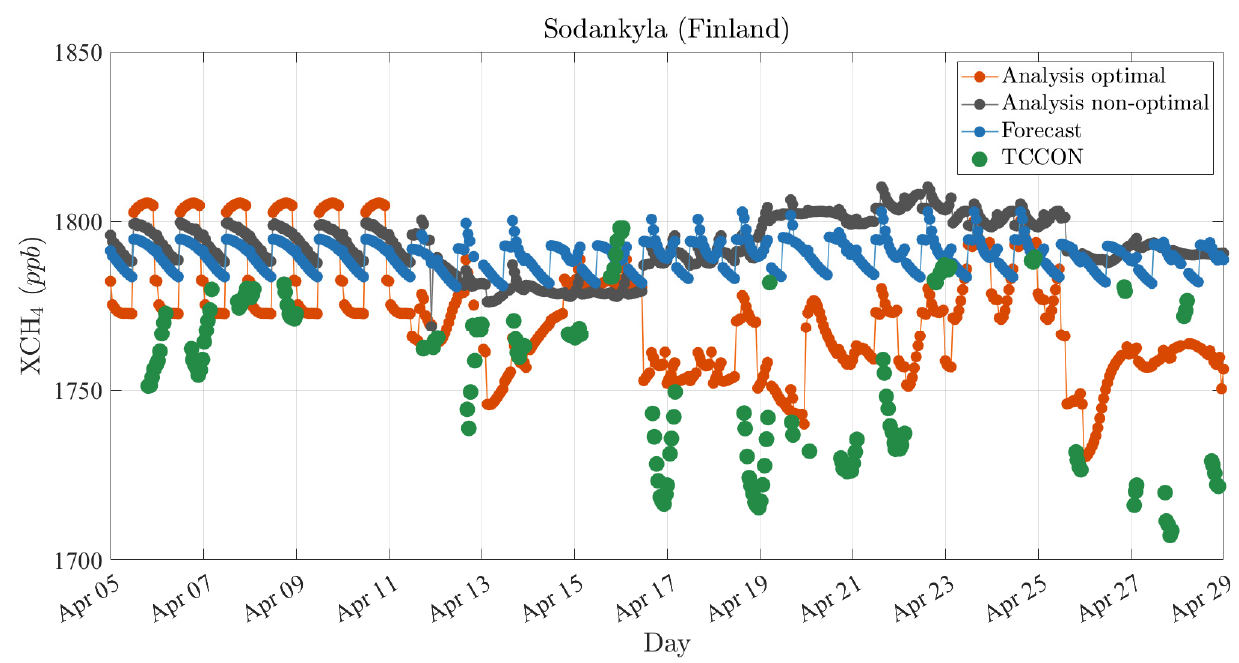
Figure 13. Comparison of model forecast (blue dots), analysis with optimal parameters (red dots), analysis with nonoptimal parameters (black dots) against Sodankylä (67.37 °N, 26.63 °E) TCCON observations (green dots). Optimal parameters of the analysis include f o = 0.5, f i = 0.45, f q = 0.018, L h = 350 km, L v = 7 σ and the nonoptimal parameters are assumed to be f o = 1.2, f i = 0.45, f q = 0, L h = 600 km, L v = 1 σ